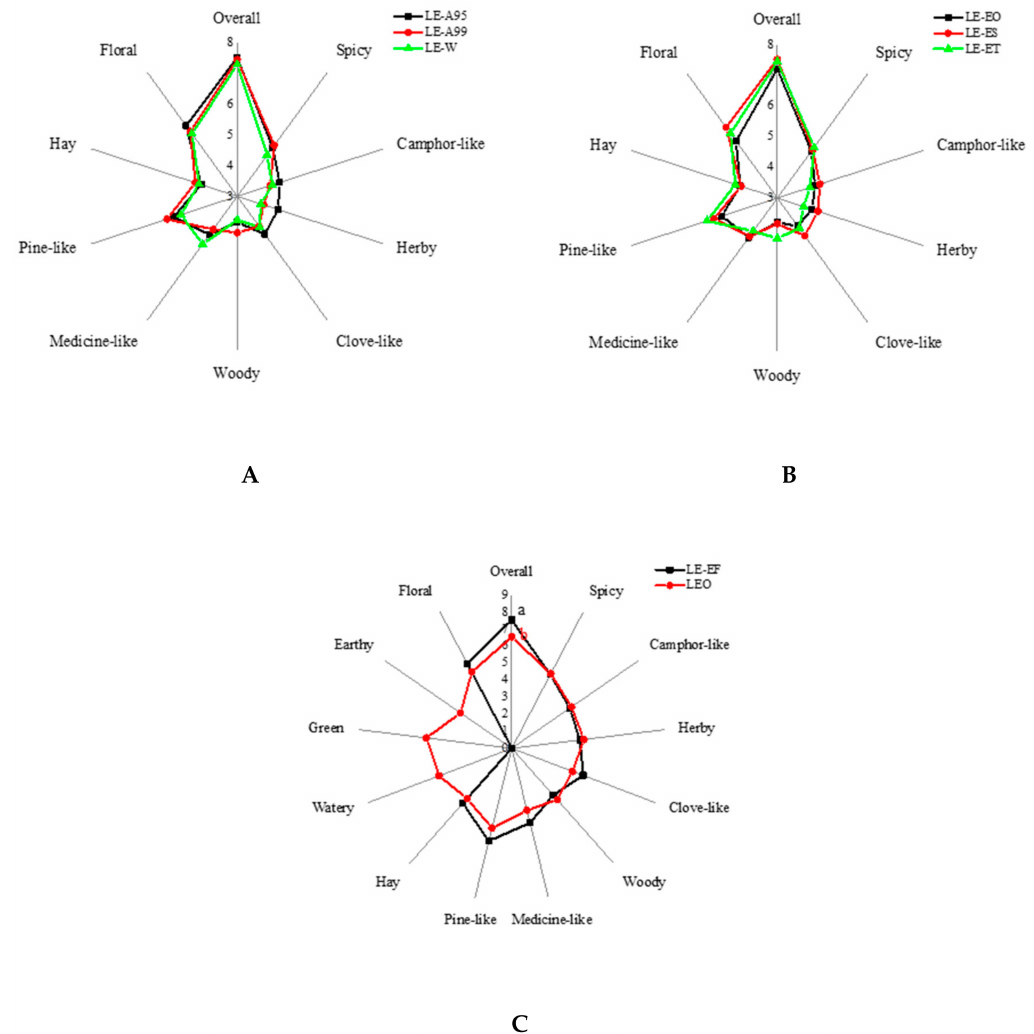
Figure 2. The odor profiles of lavender extracts and lavender essential oils. ( A ) Radar of sensory aroma attribute profile in lavender extracts with di ff erent extraction solvents. ( B ) Radar of sensory aroma attribute profile in lavender extracts with di ff erent extraction times. ( C ) Radar of sensory aroma attribute profile in lavender essential oil and lavender extracts under the optimized extraction